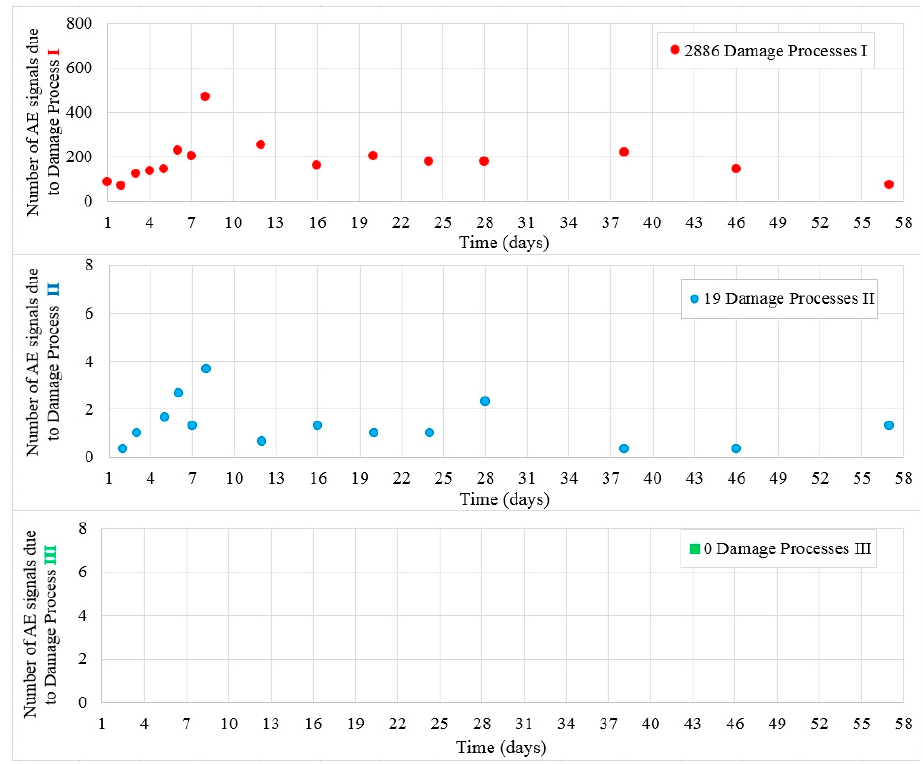
Figure 13. Number of damage processes I-III obtained from B4 samples.